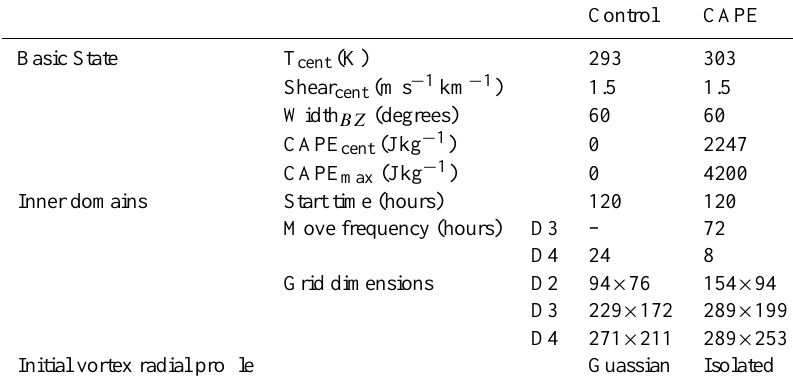
Table 1. Selected parameters for